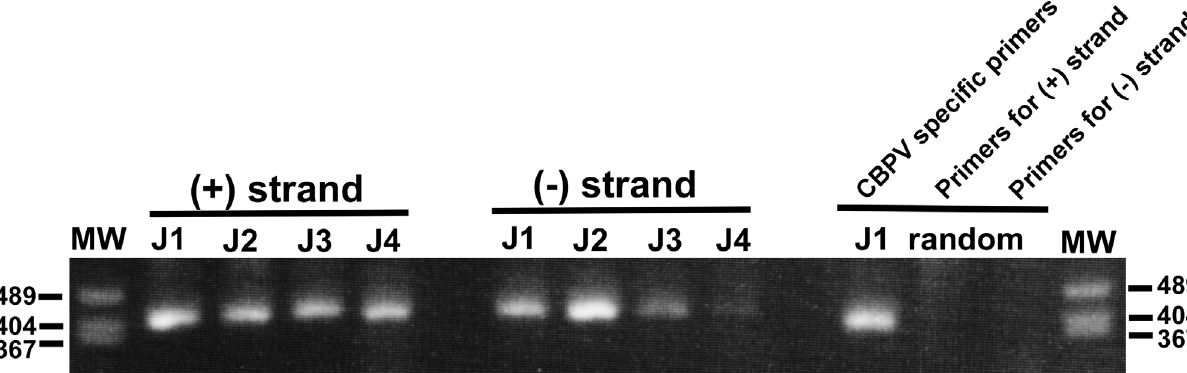
Figure 1. Molecular detection of the (+) and (−) strands of CBPV RNA2 in dying workers. (+) and (−) strands of CBPV RNA2 in dying workers from the A. mellifera Japan-1, -2, -3, and -4 colonies (J1 to J4) have been detected separately by strand-specific RT-PCR. Both (+) and ( − ) strand RNAs are present in the dying workers; however, the relative level of ( − ) strand RNA in those from the Japan-4 (J4) colony is low. Control PCR reactions were performed using CBPV cDNAs (Japan-1, J1) generated with random hexamer primers (“random”) and the CBPV-specific primers or using the two sets of primers used for detecting the (+) and ( − ) strands of CBPV RNA2. The sizes of three bands of the molecular weight marker (MW) are shown on both sides of the